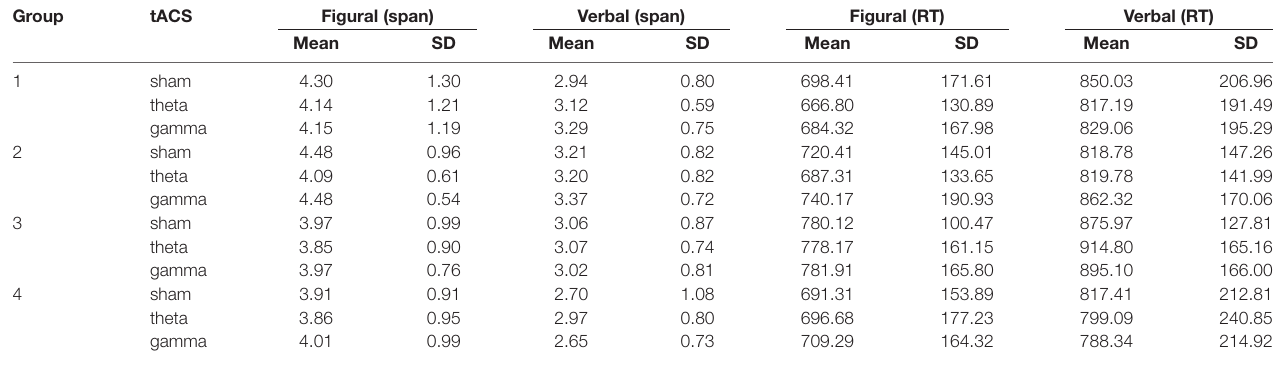
TABLE 3 | Average scores (span) and reaction times (in ms) on change detection tasks in sham, theta and gamma tACS sessions for each group.